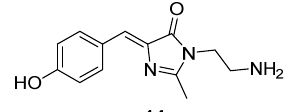
Figure 14. GFPc analogues that can be conjugated with the TMV channel [28]. A GFPc has been modified in order to increase its affinity for β -amyloid fibrils and lysosomes (chromophore 15 , Figure 15). The phenolic hydroxyl group of the GFPc has been replaced by a dimethylamino group, and a quinolone substituent has been introduced, in order to improve the affinity with β -amyloid fibrils. The 3-morpholinopropyl-amino group has been added as a lysosome-targeting group [29]. The GFPc 15 demonstrated to accumulate in the β -amyloids, which mimic the environment of the β -barrel of the GFP, thus turning on the fluorescence. The same effect was observed with lysosomes. Therefore, GFPc 15 allowed the detection of A β fibrils and the mapping of viscosity in lysosomes, with fluorescence emissions at 570 nm and 600 nm, respectively.